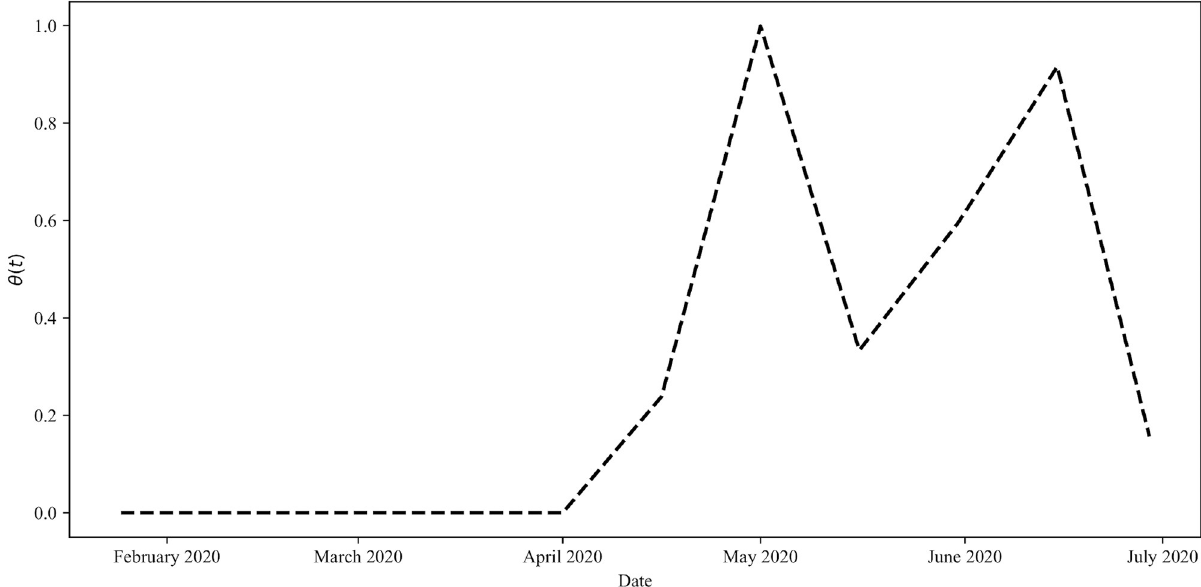
Fig 3. Public-response function fitting. The public-response function θ ( t ) between January 25, 2020 and June 30, 2020. The function is a continuous, piecewise-linear function with intervals of 15 days. https://doi.org/10.1371/journal.pone.0249456.g003 To demonstrate the sharp sensitivity of this condition, we plot visible infection trajectories of the Distancing-SERID model, Eqs (3) and (4), in Fig 4 for three separate values of θ three trajectories use the same parameter set from Table 1 and the form of θ ( t ) from Eq (5) with the addition that θ ( t ) = θ for t > t . However, in the first trajectory, we consider f c